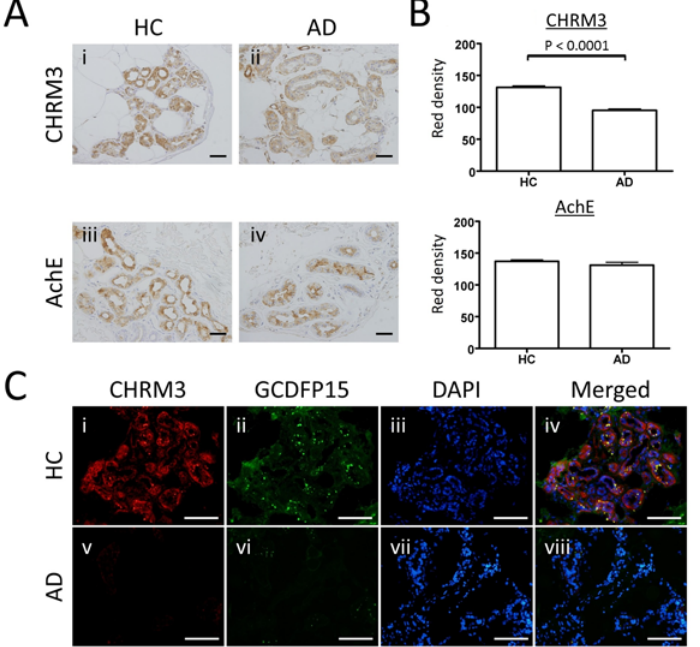
Fig 4. Expression of cholinergic receptor muscarin 3 and acetylcholine esterase in eccrine gland secretory coil of normal and atopic dermatitis skin specimens. (A) Representative immunohistochemical staining of cholinergic receptor muscarin 3 (CHRM3) and acetylcholine esterase (AchE). Bars indicate 50 μ m. (B) The staining intensities are expressed as RD. The RD of CHRM3, but not AchE, is significantly lower in AD patients. Results are expressed as mean ± SEM. (C) Double immunofluorescence staining of CHRM3 and GCDFP15 in the eccrine gland secretory coil. In eccrine gland secretory coil cells, the expression levels of CHRM3 and GCDFP15 are decreased in parallel in AD. Bars indicate 50 μ m.